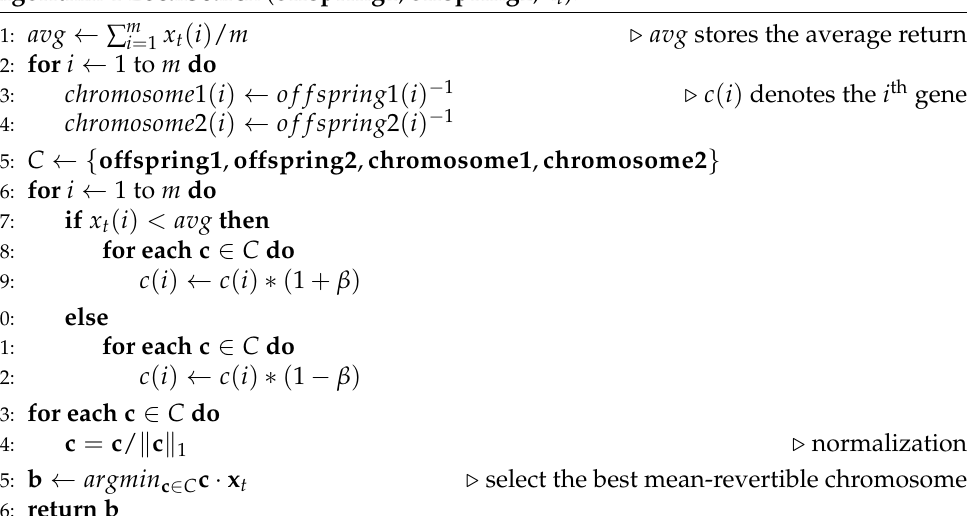
Algorithm 4 LocalSearch ( offspring1 , offspring2 , x t